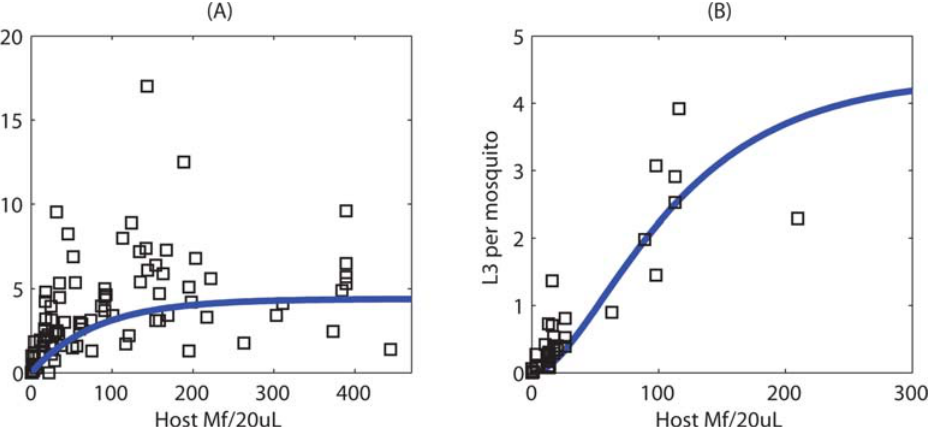
Figure 1. Functional forms relating microfilaria (Mf) uptake (from 20 m L host blood) and L3 development per mosquito in each vector genus. The squares denote observed data for each vector respectively (sources outlined in the text). The curve fitted to the (A) Culex data is a limiting function of Mf (equation 6 in the text) whereas the Anopheles curve in (B) describes a development response that begins with a facilitation phase which then approaches an upper limit at higher Mf uptakes (equation 9 in the text).